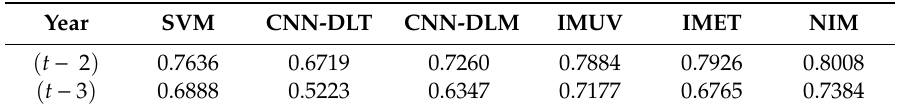
Table 6. The out-of-sample forecasting AUC scores of each model with the comprehensive training data set of the year ( t − 2 ) and ( t − 3 )